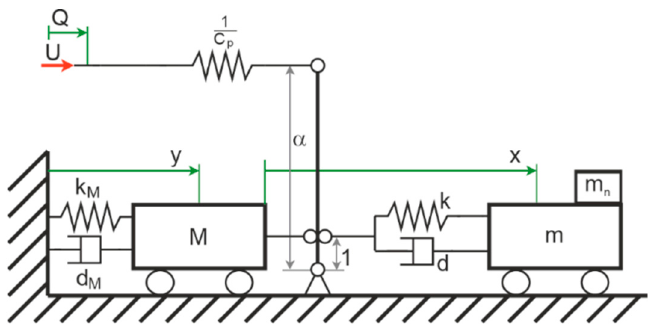
Figure 3. Simplified equivalent model for the co-resonant mass detector.